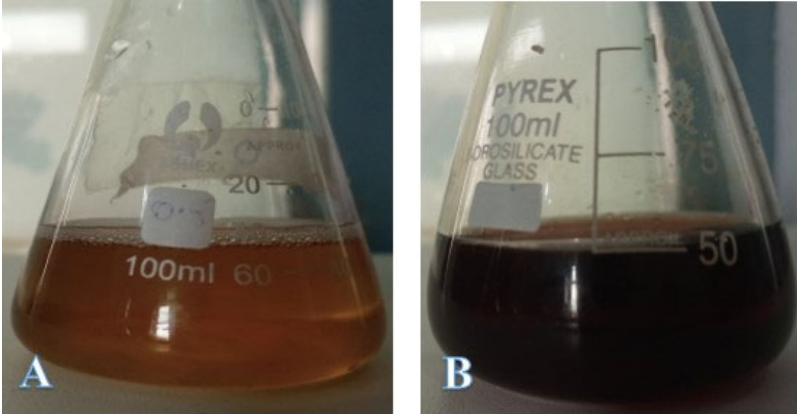
Figure 3. Photographs of leaf extract of Euphorbia wallichii ( A ) and reaction mixture containing AgNO 3 solution (4 mM) and E. wallichii leaf extract ( B ).